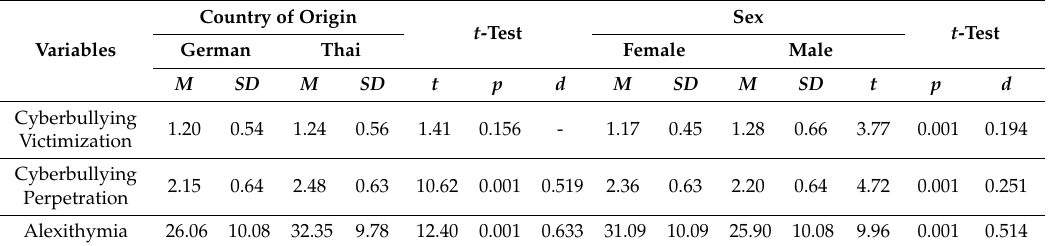
Table 1. Bivariate differences in the study variables by sex and country of